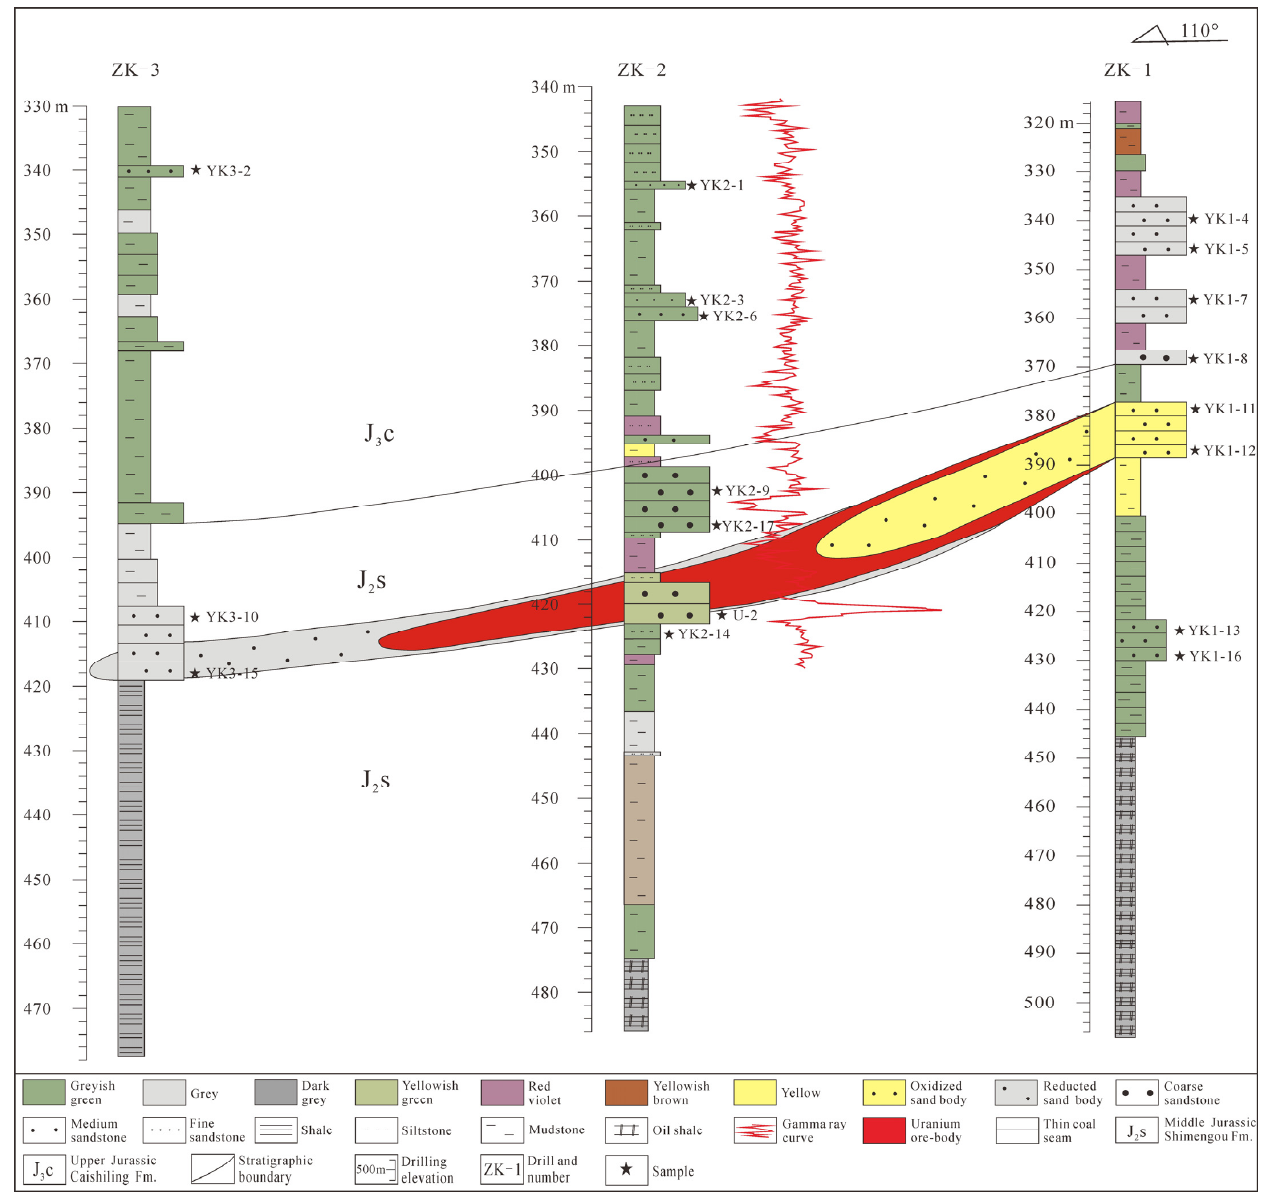
Figure 2. A drilling section of Yuqia sandstone-type uranium deposits.